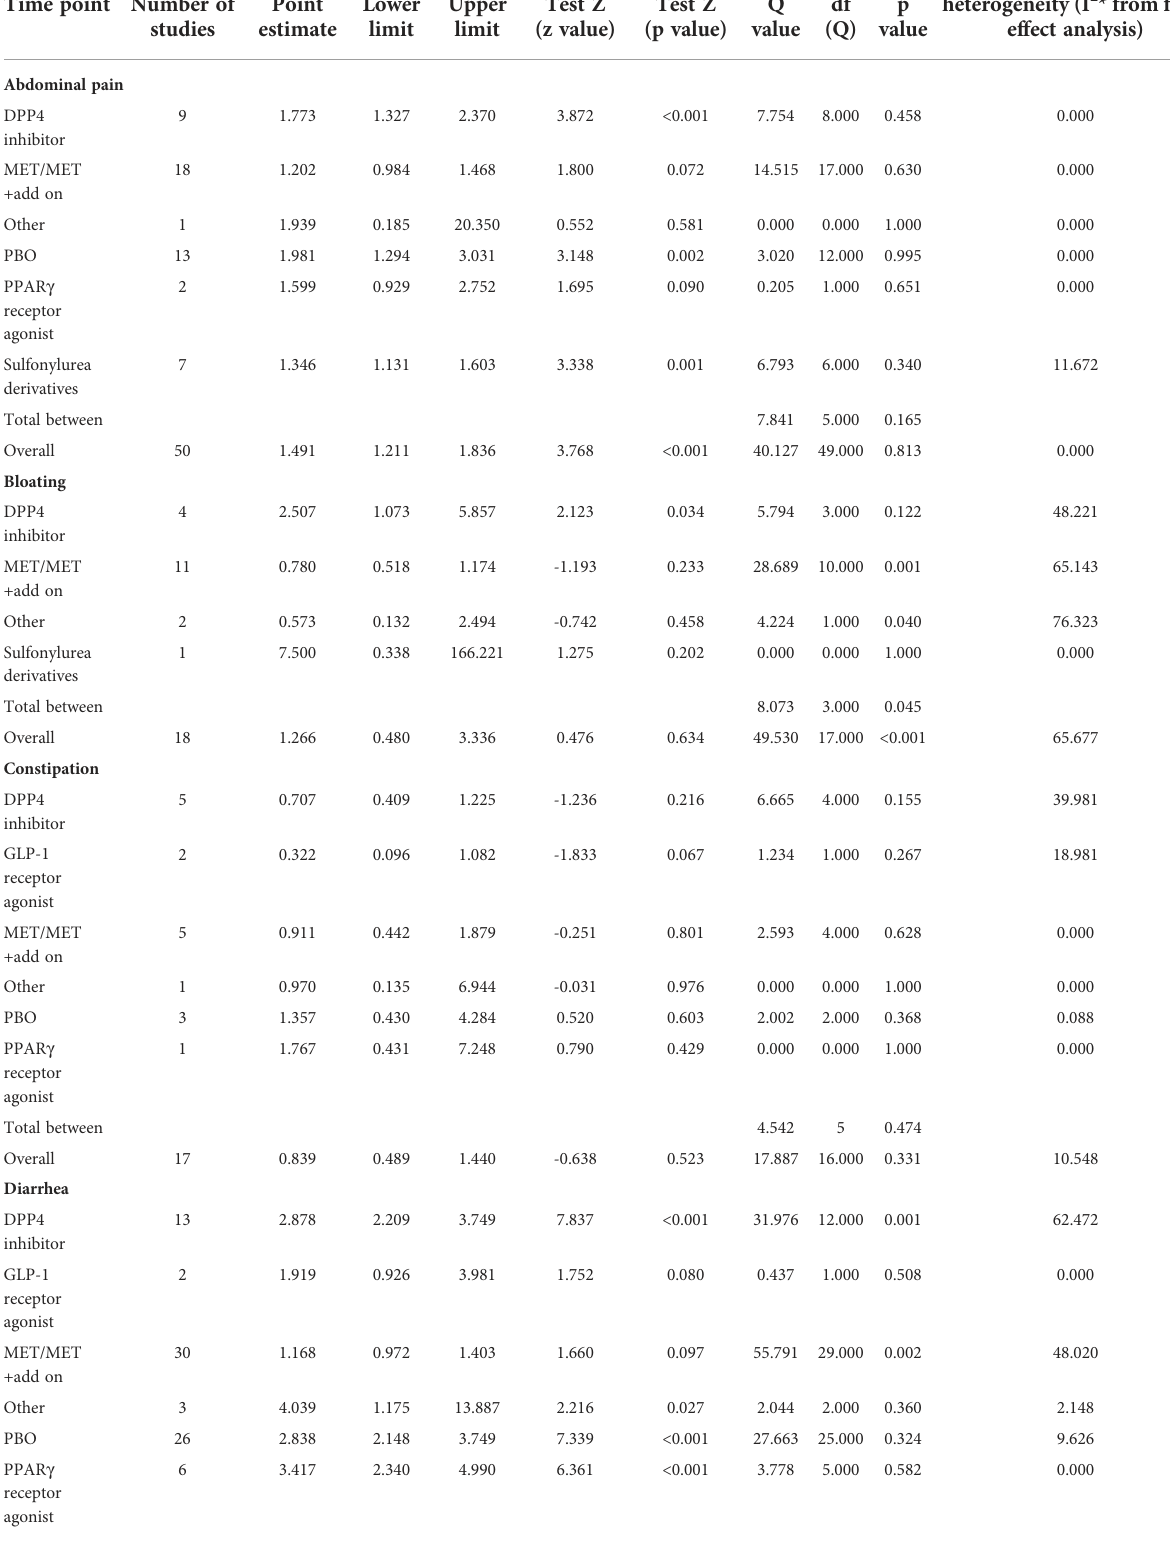
TABLE 2 The effect sizes of all study